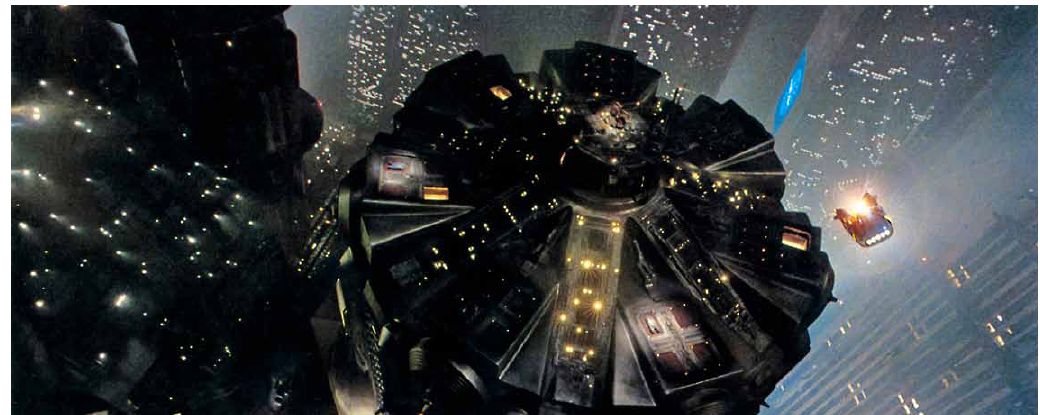
fig. 14. Spinner (flying vehicle) landing on a building in Blade